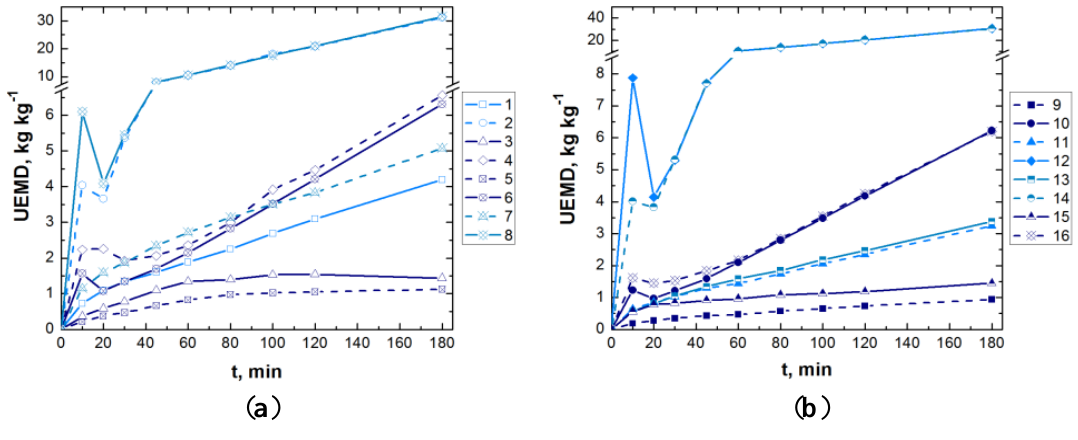
Figure 6. Evolution of unit electrode material demand (UEMD) during EC /CAG coupling (experimental conditions are depicted in Table 3; solid line— DC , dashed line— APC ; light blue, blue and navy blue lines—low, center and high values of dye